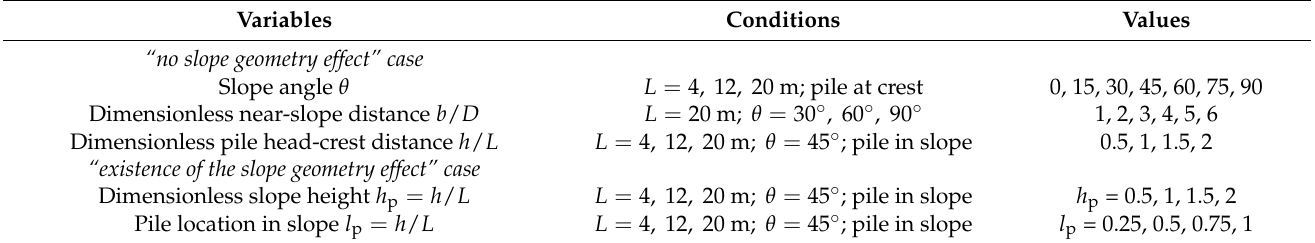
Table 4. Variables